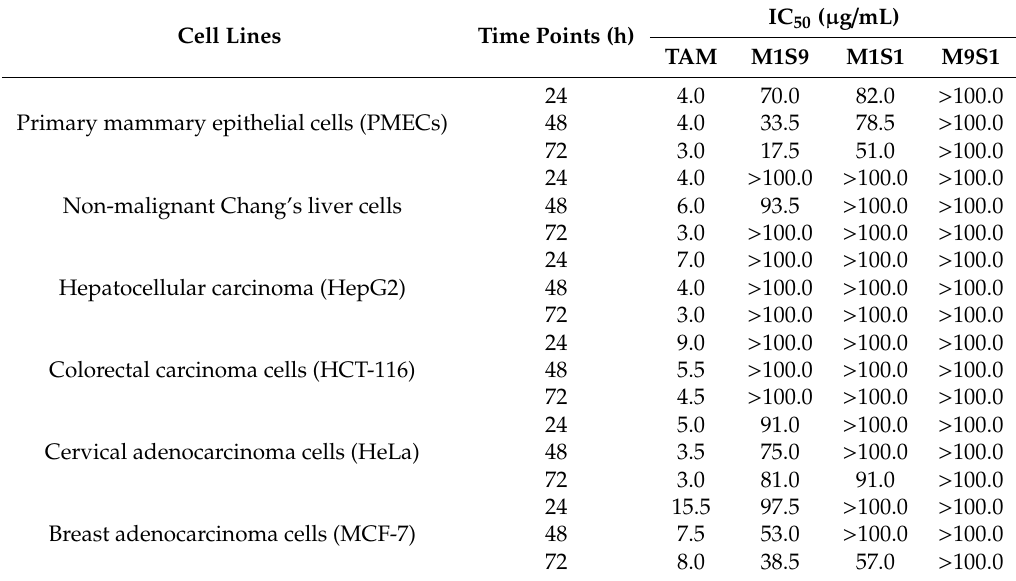
Table 3. The IC 50 values of tamoxifen (TAM) (positive control) and combined mixture of moringa leaves and seed residue (MOLSr) extracts at di ff erent ratios (M1S9, M1S1 and M9S1) after 24, 48 and 72 h of treatment with respective cell